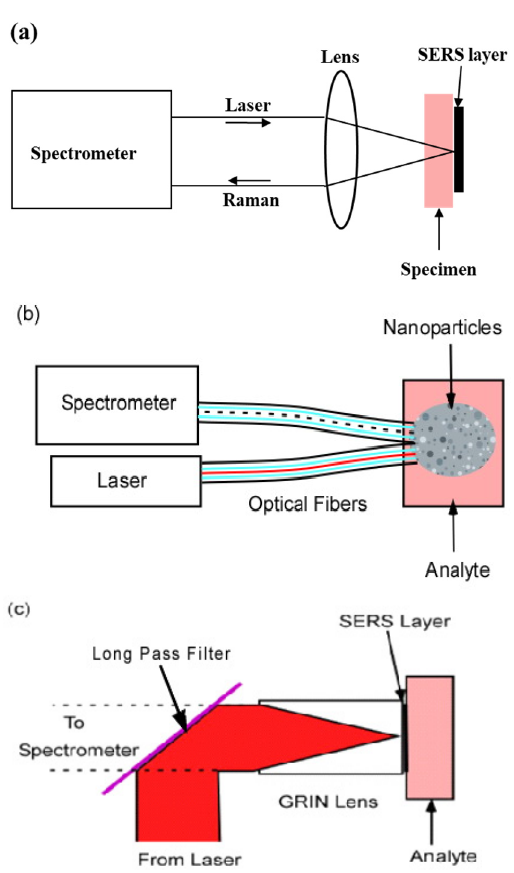
Figure 1. ( a ) In vitro sample configuration. The specimen is brought to the laser/spectrometer combination; ( b ) in vivo sample configuration. The SERS nanoparticles are injected as a cloud into the specimen; ( c ) GRIN lens probe. The SERS layer on the GRIN lens is brought to the surface or the interior of the specimen.